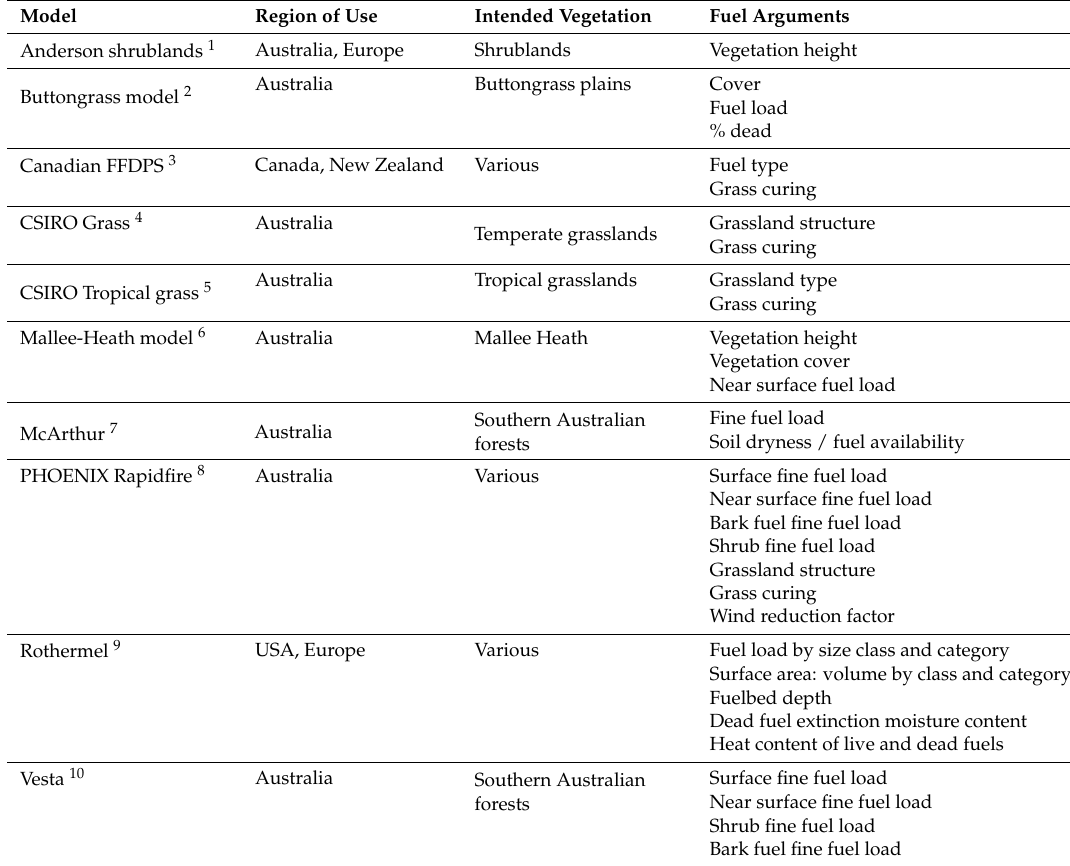
Table 1. Selection of fire models used for operational faster-than-real-time fire behaviour prediction by landscape managers, and the fuel input arguments required for their computation *. The models presented utilise unique functions for deriving fire behaviour from fuel. Modelling systems that utilise these functions are not considered